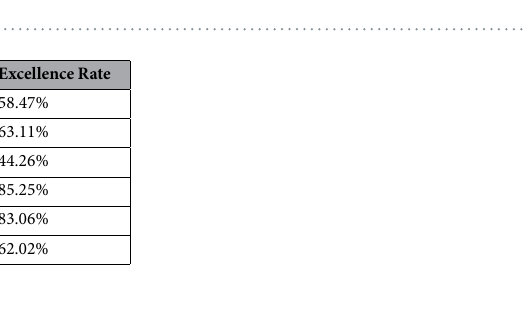
Figure 1. Map of study area. The map was generated using ArcGIS (Version 10.3.1., https://www.arcgis.com). The source of the map is GADM database of Global Administrative Areas (http://www.gadm.org/). The study area is part of the map of China.